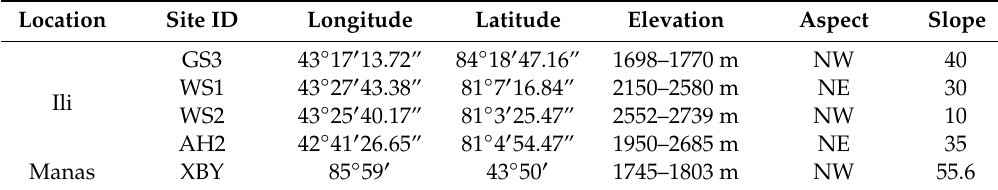
Table 1. Site coordinates and statistics for the four sampling sites of Ili River Basin and one sampling site of Manas River Basin. The tree species was Picea schrenkiana